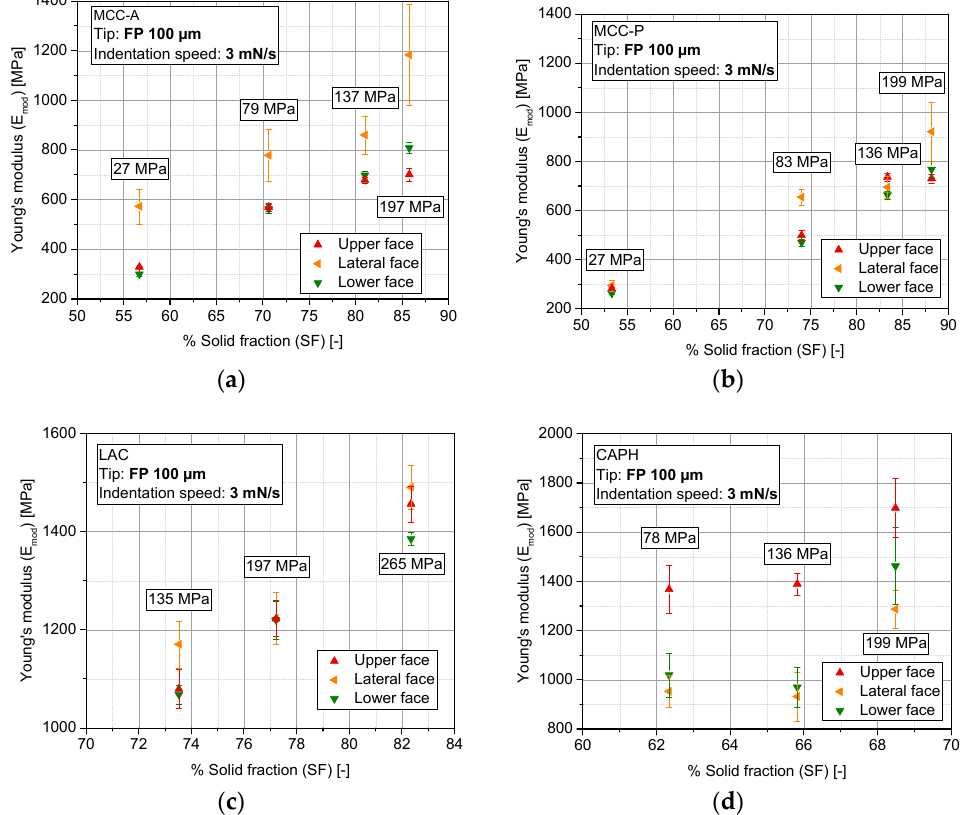
Figure 13. Elastic modulus as a function of the solid fraction of tablets for different excipients; ( a ) MCC-A; ( b ) MCC-P; ( c ) LAC; ( d ) CAPH. Sampling size: eight tablets per solid fraction (SF) and face, 164 indents at each tablet.